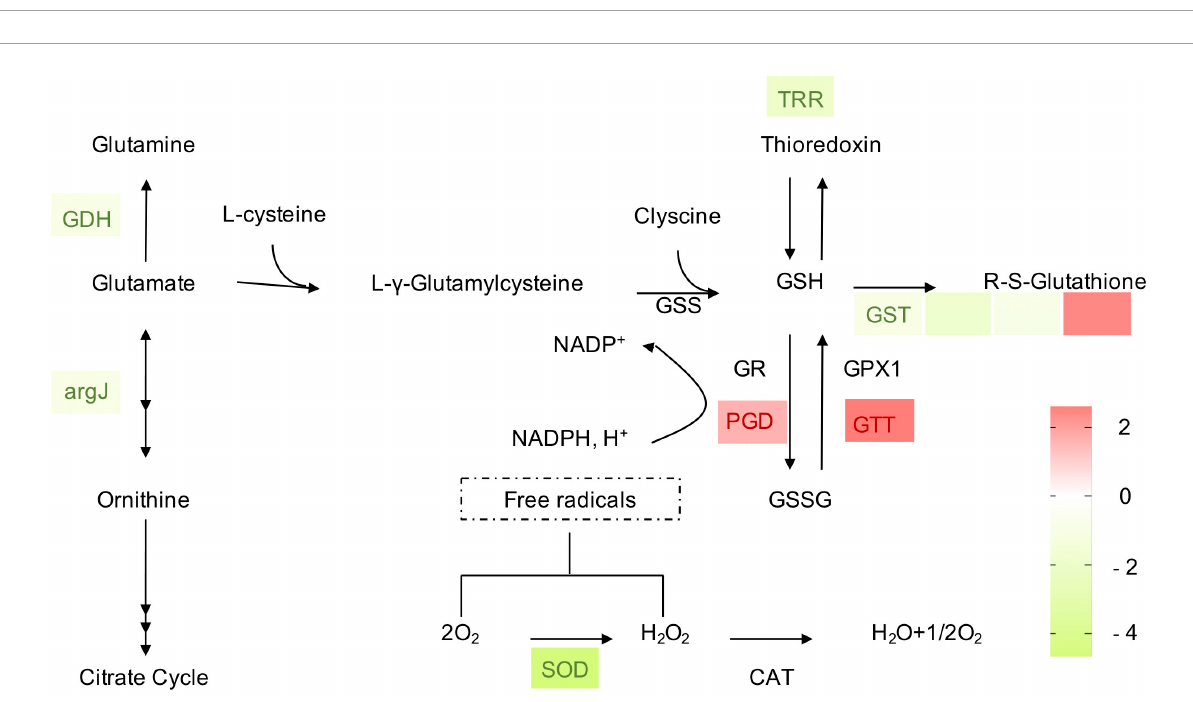
FIGURE9 Heat maps of differentially expressed genes (DEGs) that may be involved in redox homeostasis. GDH, glutamate dehydrogenase; argJ, amino-acid acetyltransferase; GSS, glutathione synthase; GSH, glutathione; GR, glutathione reductase; PGD, 6-phosphogluconate dehydrogenase; GPX, glutathione peroxidase; GTT, glutathione transporter; GSSG, glutathione disulfide; GST, glutathione S -transferase; TRR, thioredoxin reductase; SOD, superoxide dismutase; CAT, catalase. The expression image was generated using GraphPad Prism software: red, increase; green,